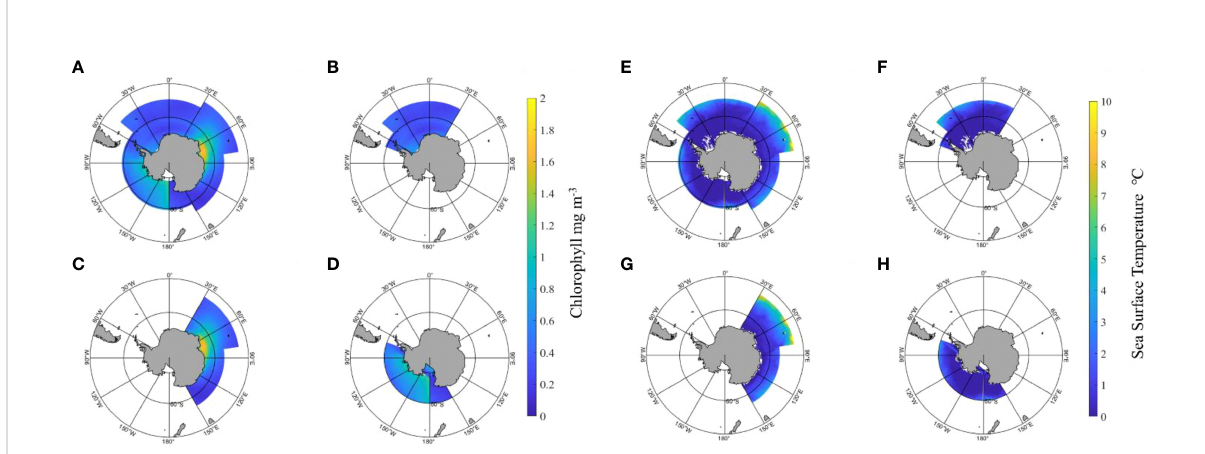
FIGURE 12 Distribution of chlorophyll and sea surface temperature in the main fi shing areas of the polar region. (A – D) is the chlorophyll distribution, and (E – H) is the sea surface temperature distribution. (A, E) are the total fi shing area, (B, F) are FA 48, (C, G) are FA 58, and (D, H) are FA